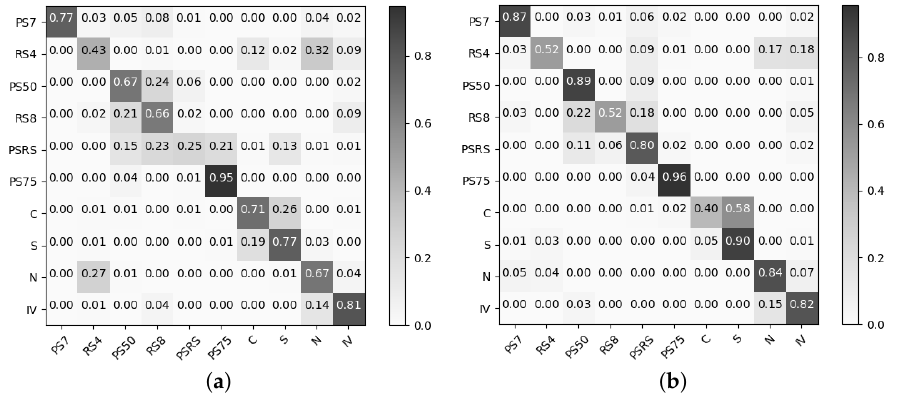
Figure 8. Normalized confusion matrices for ( a ) MLP and ( b ) SDGM trained on 100 randomly sampled and evenly distributed labeled data points. The x-axis shows the predicted labels, and the y-axis the true